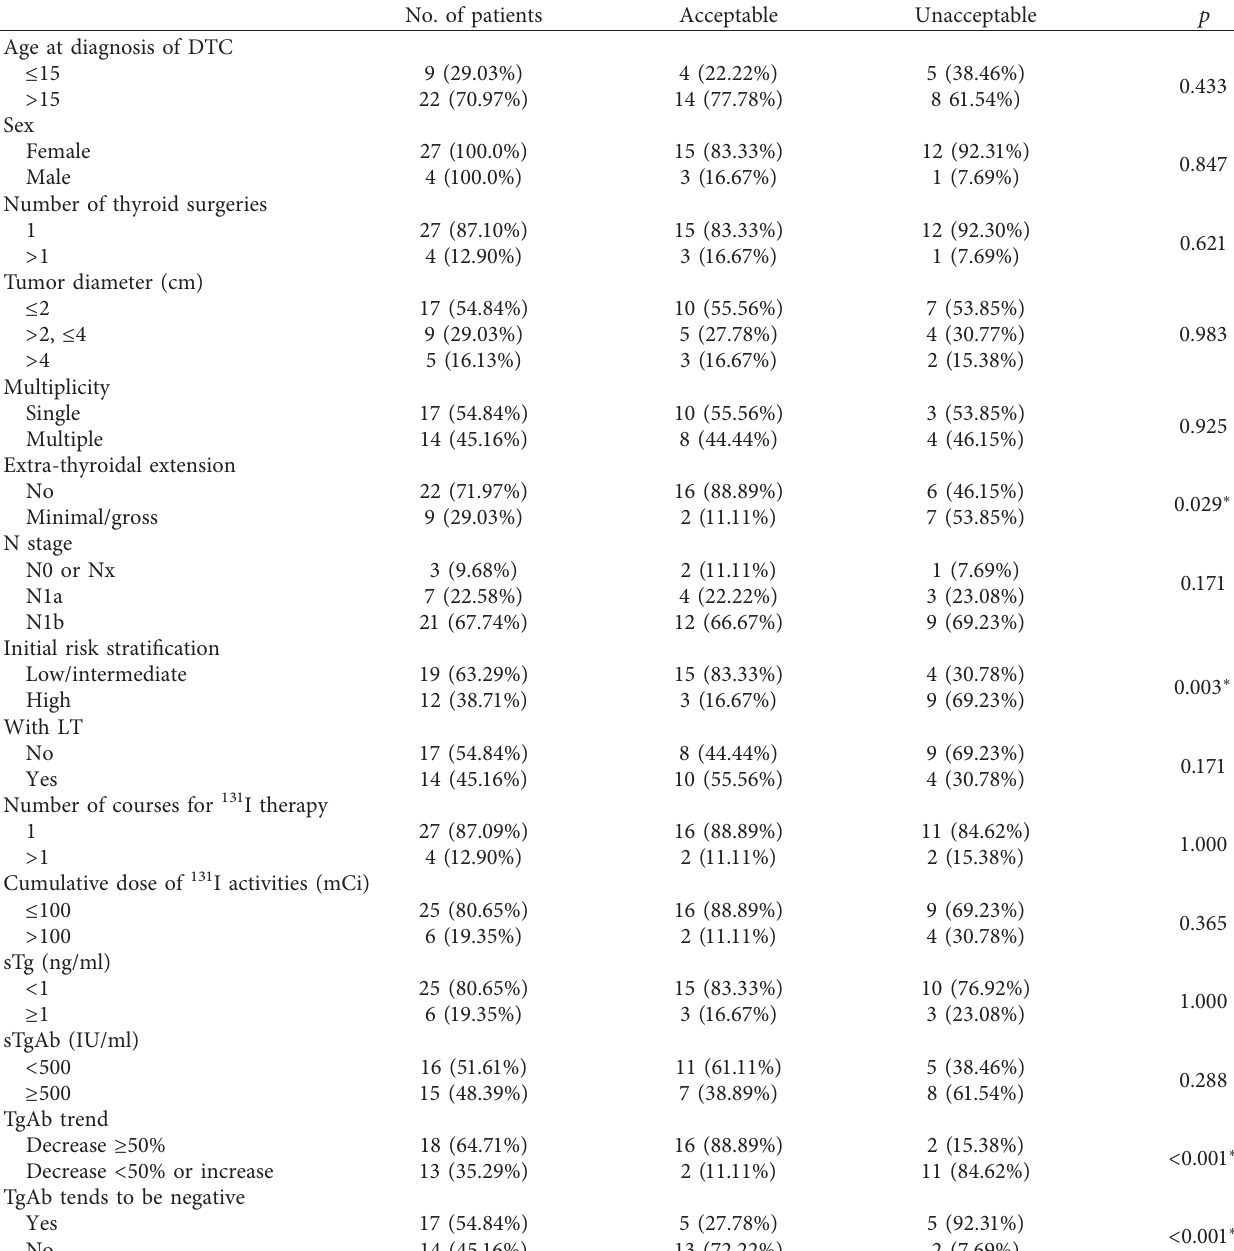
Table 5: Univariate analysis for clinicopathologic factors associated with responses to therapy in N-Tg groups. No. of